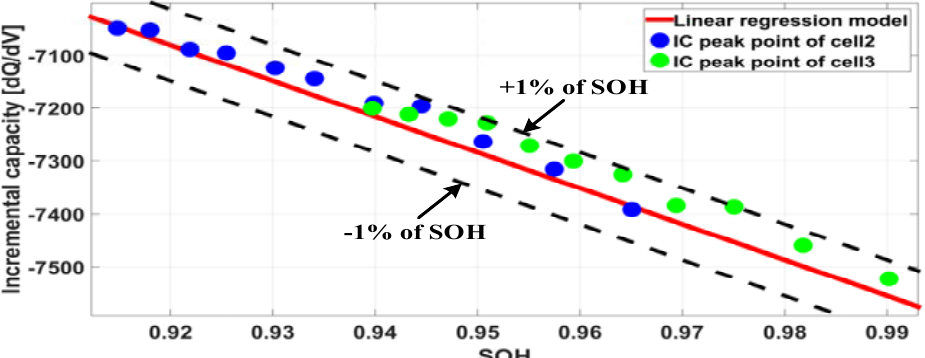
Figure 16. Comparison between the linear regression model based on the IC curve peak point of cell no. 1 and a real SOH based on two IC curve peak points of cell nos. 2 and 3.